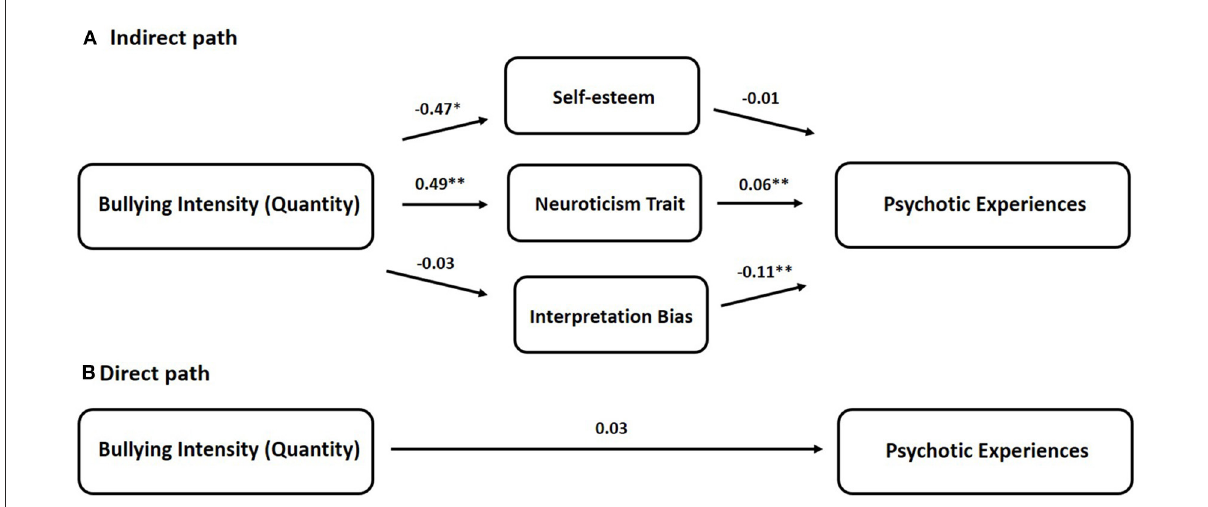
FIGURE1 The multiple mediator model for bullying intensity (Quantity) on psychotic experiences. (A) Indirect path and (B) direct path. Unstandardized coefficient ( b ) presenting the effect of school bullying on mediators and scores of Psychotic Experiences (PE). Significant effect was found for the total effect of bullying quantity on PE scores ( p = 0.0001), and borderline significant effect was found for the direct effect of bullying intensity (quantity) on PE scores ( p = 0.058). The multiple-mediator model accounting for 15.96% of the variance in PE scores [ F (4,257) = 12.04, p < 0.001]. *Significant at p < 0.05, **Significant at p <